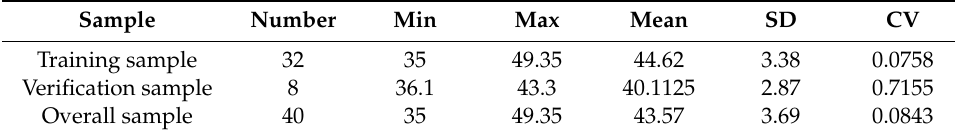
Table 2. Descriptive statistics of peanut canopy single-photon avalanche diode (SPAD).